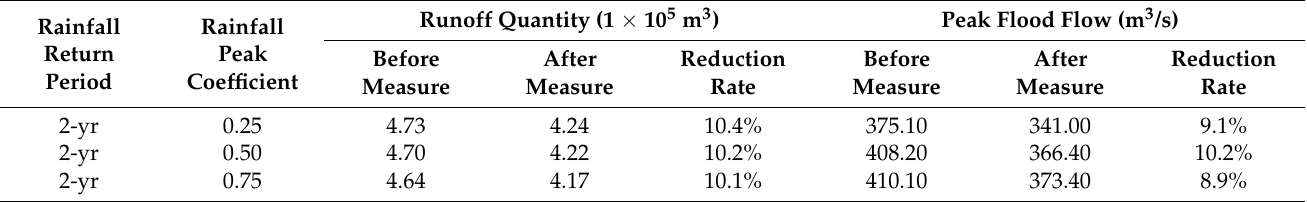
Table 9. Analysis on surface runoff under different rainfall peak